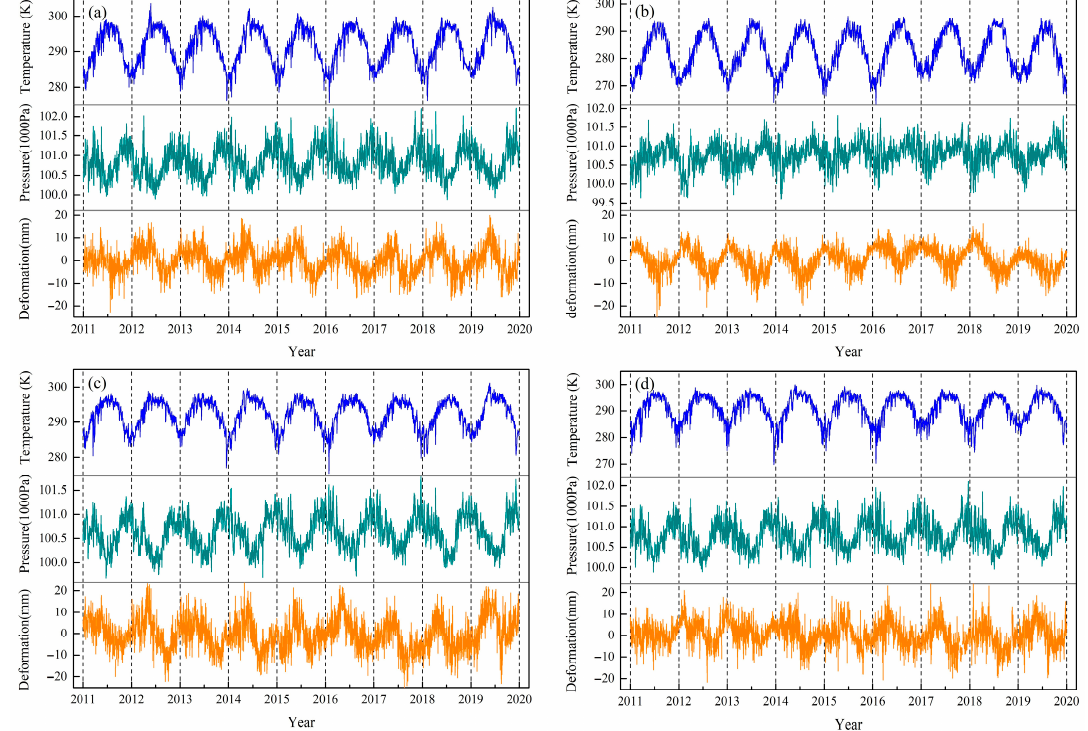
Figure 2. The sequences of vertical deformation (orange line), temperature (blue line), and atmospheric pressure (green line) on the GPS stations of SCPZ ( a ), SCXJ ( b ), YNMJ ( c ), and YNML ( d ), respectively.